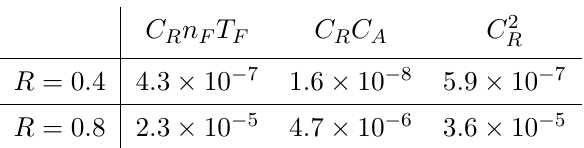
Table 1 . Reference values for δ C ( R 2 ) , as defined in eq. (4.4).